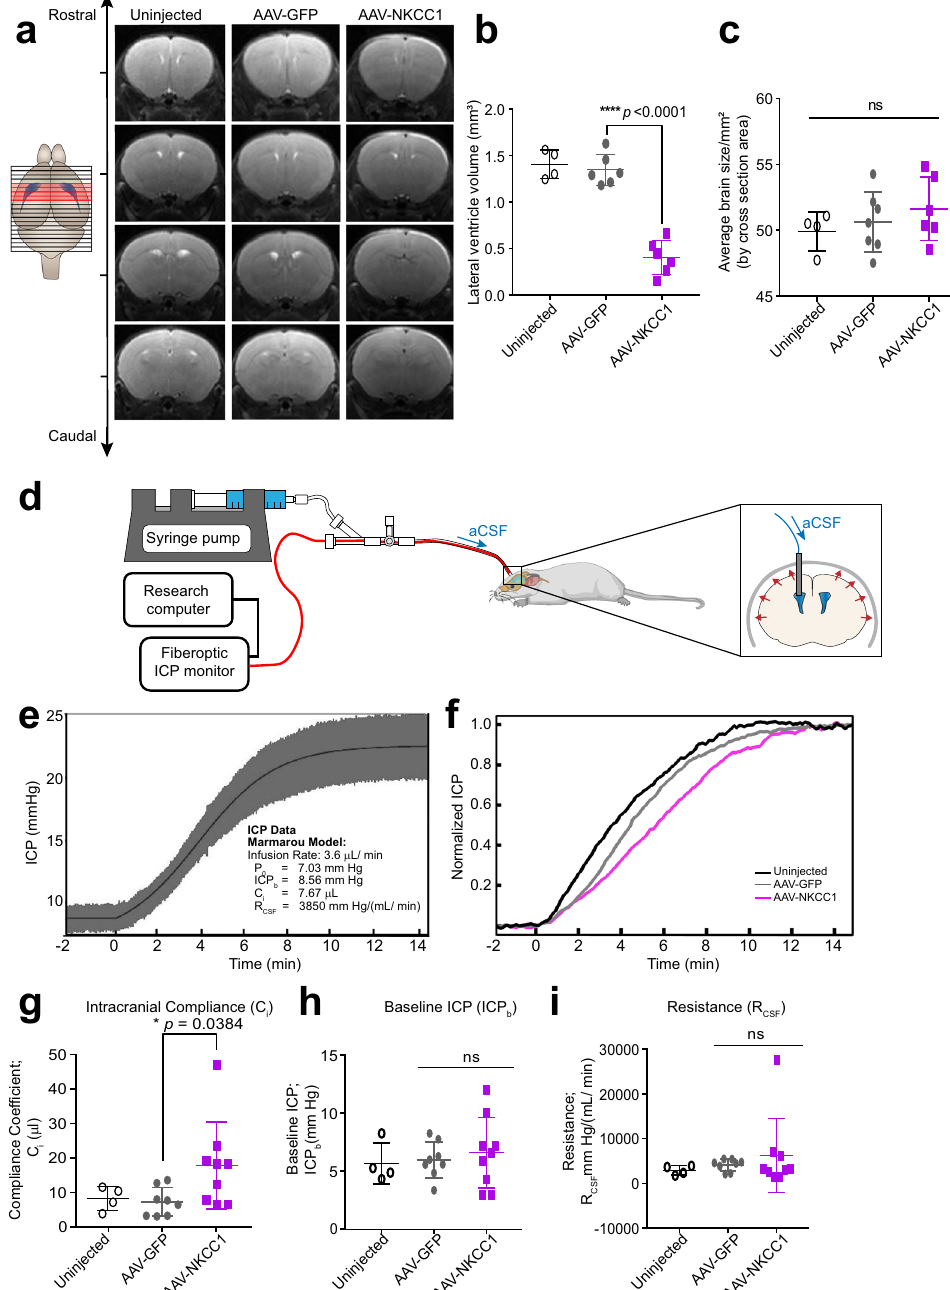
Fig. 5 ChP NKCC1 overexpression reduces brain ventricular volume and increases intracranial compliance. a T2-weighted live MRI images. Only slices with visible lateral and 3rd ventricles are shown (marked red in the schematics; for NKCC1 OE mice, slices matching with control mice are shown regardless of ventricles). b Lateral ventricle volumes. Uninjected N = 4; AAV-GFP and AAV-NKCC1 N = 6, from two independent experiments; Black with no fi ll: uninjected; gray: AAV-GFP; purple: AAV-NKCC1 (the same color scheme is used for the rest of this fi gure). **** p < 0.0001; Welch ’ s two-tailed unpaired t -test. c Brain sizes, which are presented as the average coronal section area from all images with visible lateral and 3rd ventricles (marked red in the schematic; NKCC1 OE data were calculated using the matching images to the controls, regardless of ventricles visibility). Uninjected N = 4; AAV-GFP and AAV-NKCC1 N = 6 (same as mice included in panel b ); Welch ’ s two-tailed unpaired t -test. d Schematic of in vivo constant rate CSF infusion test. e Example of ICP curve during the infusion test (infusion begins at 0 min) in an AAV-GFP mouse, fi tted to Marmarou ’ s model. Values extracted include: baseline ICP (ICP b ), a pressure-independent compliance coef fi cient (C i ) and the resistance to CSF out fl ow (R CSF ). f Example ICP recordings from AAV- NKCC1 mice and controls. For clarity, data have been low pass fi ltered to remove the waveform components. g Compliance coef fi cients. Uninjected N = 4; AAV-GFP N = 8; AAV-NKCC1 N = 9; 3 total independent experiments. * p = 0.0384; Welch ’ s two-tailed unpaired t -test. h , i Plots of baseline ICP and resistance to CSF out fl ow (R CSF ) at 5 – 7 weeks. Uninjected N = 4, AAV-GFP N = 8, AAV-NKCC1 N = 9; 3 total independent experiments (same experiments as those included in g ). Welch ’ s two-tailed unpaired t -test. All quantitative data are presented as mean ±